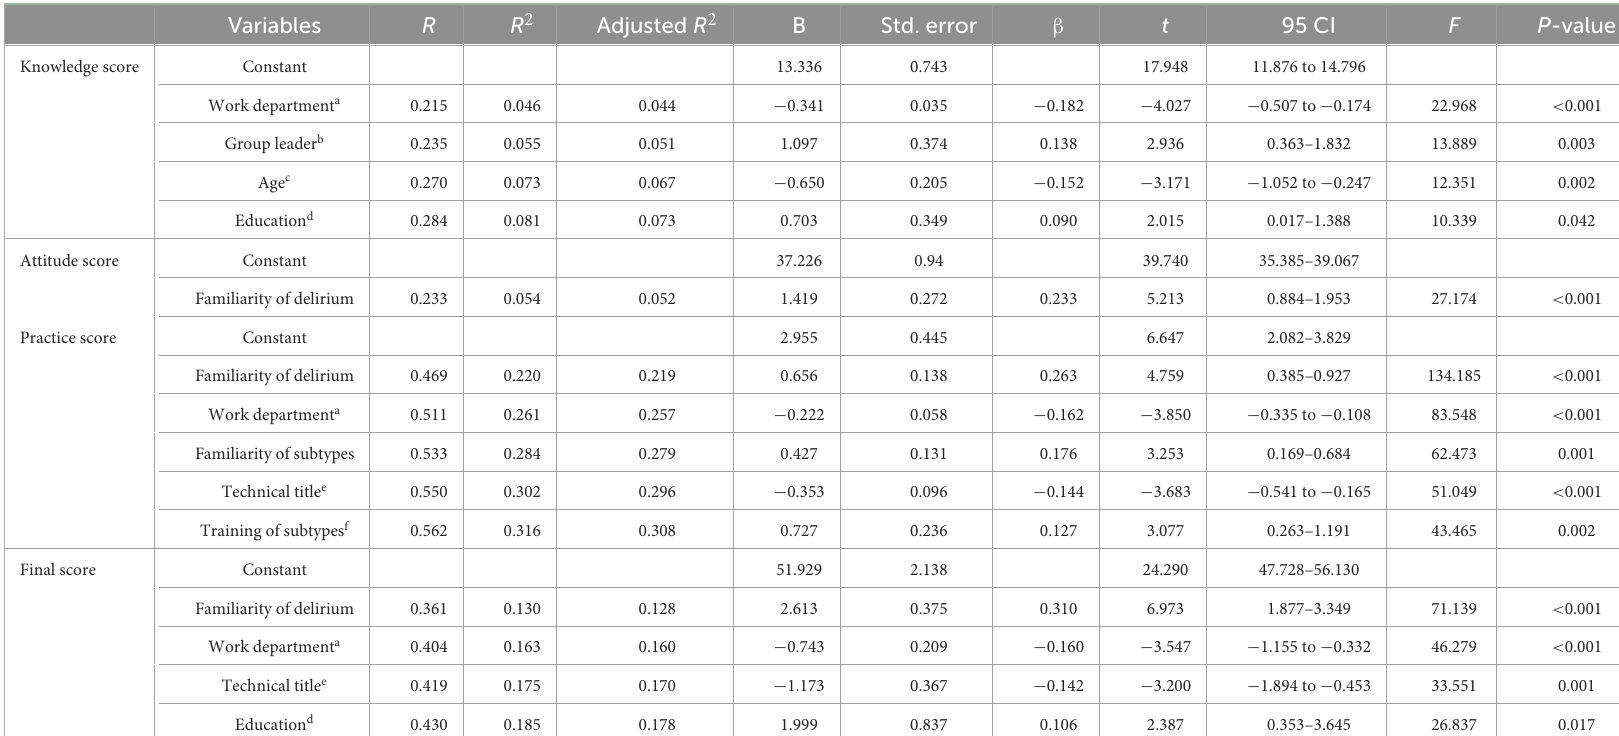
TABLE 4 Multiple linear stepwise regression analysis of delirium and subtype assessment for clinical nurses ( n =